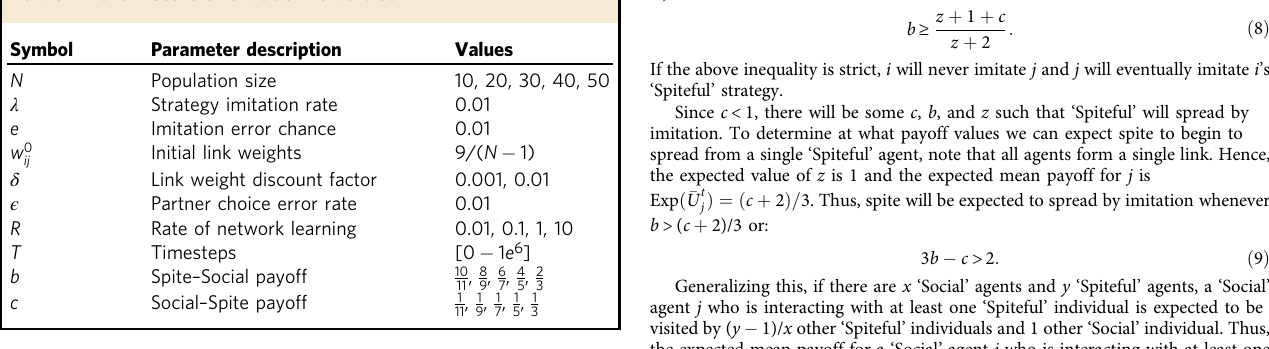
Table 1 Parameters and baseline